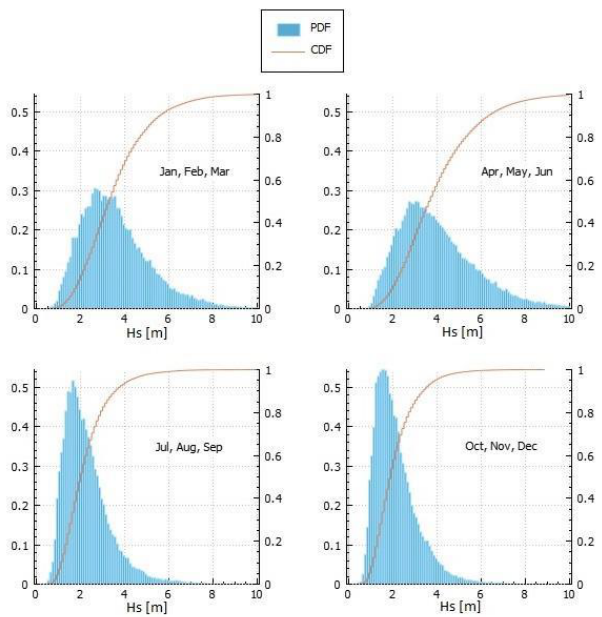
Fig. 6. Seasonal distribution of significant wave height at